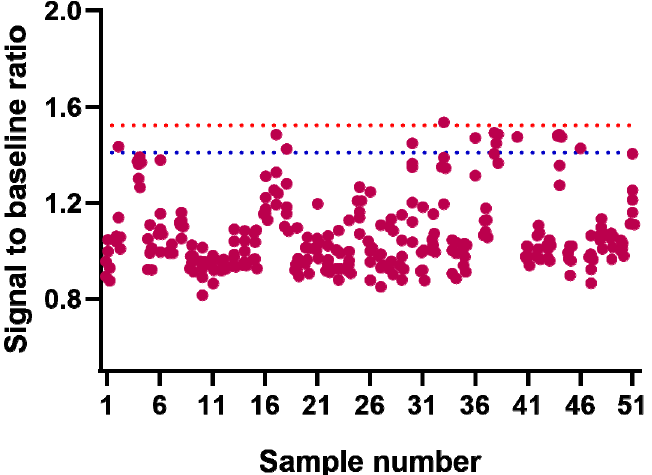
Figure 1. The cut point for the screening assay and titration assay. The screening and titration assays were carried out in six runs by three analysts. The screening cut point (SCP) is indicated with a blue dotted line, and the titration cut point (TCP) is indicated with a red dotted line.